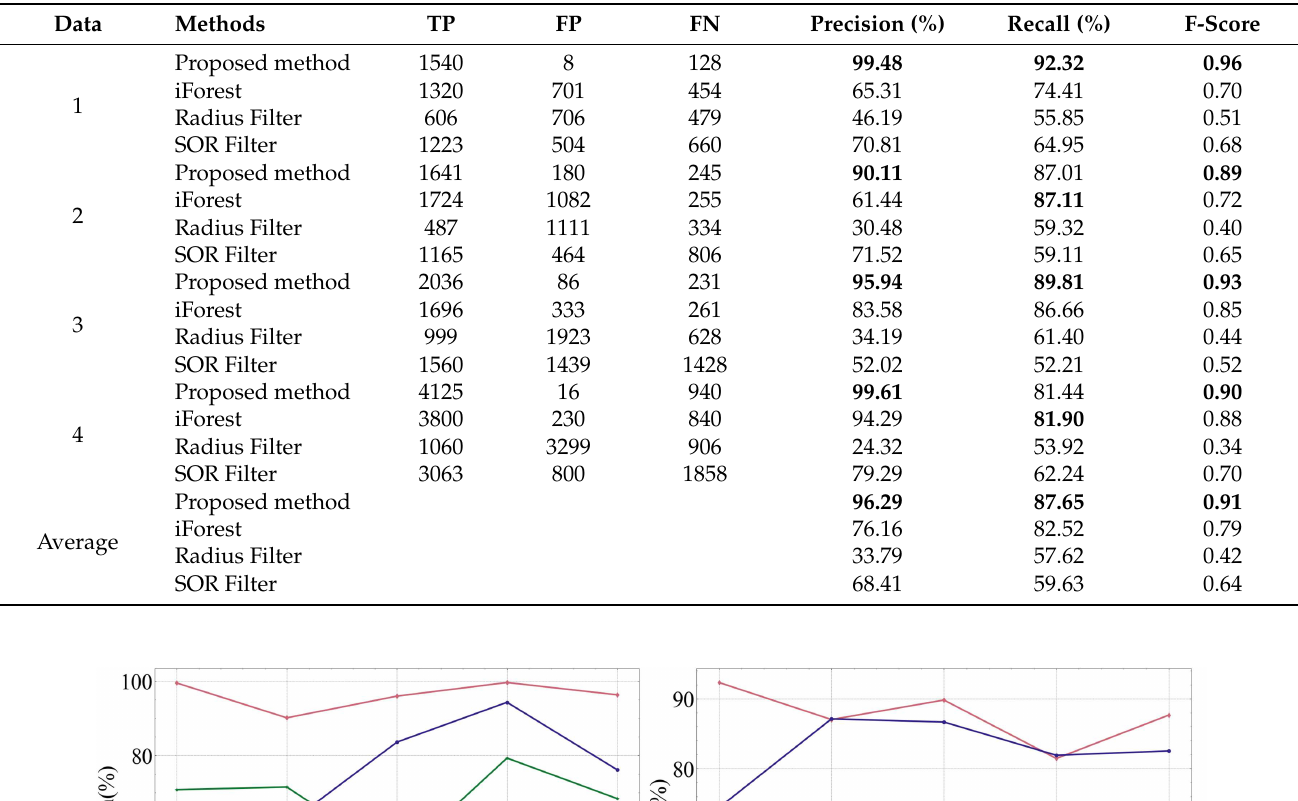
Table 3. Accuracy evaluation of trunk denoising experiment.